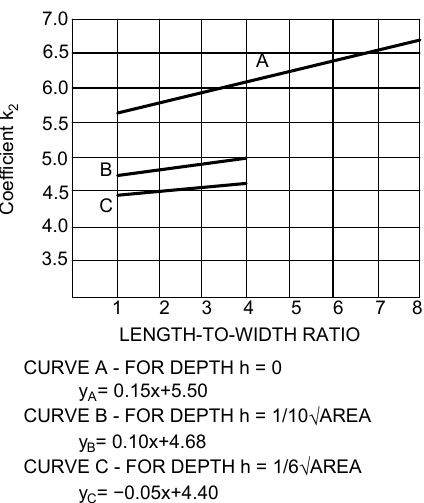
Figure 3. Coefficient k 2